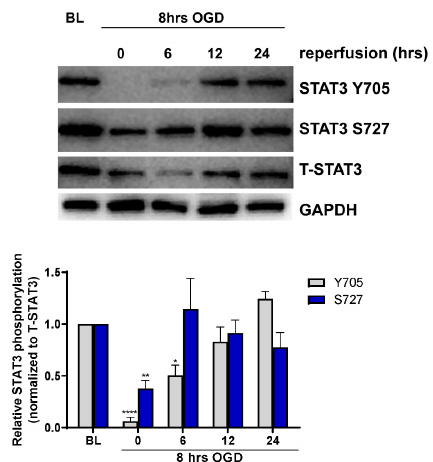
Figure 1. Regulation of STAT3 phosphorylation by OGD. ECs were subjected to 8 h of OGD followed by return to normal glucose and oxygen conditions for 0, 6, 12 and 24 h before being harvested for Western blot analysis. Blots were probed for phospho-STAT3 (Y705), phospo-STAT3 (S727), total STAT3 (T-STAT3) and GAPDH. Phosphorylation following OGD was compared to non-OGD con- trols (baseline; BL). Phosphorylation on both Y705 and S727 residues was reduced following OGD, returning to baseline levels during reperfusion. n = 7; * p < 0.05, ** p < 0.01, **** p < 0.0001, 2-way ANOVA. Data are presented as mean ± SEM.